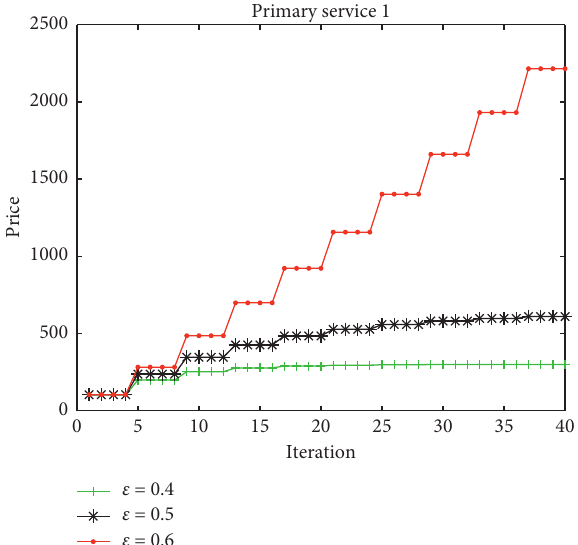
Figure 3: The relationship between price and iteration on ε � 0.5 for four PSPs.